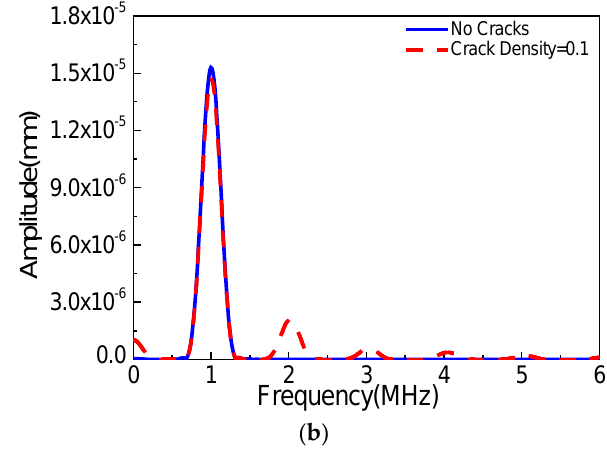
Figure 5. Wave signals in the x direction ( a ) time domain; ( b ) frequency domain ( c = 0.1, f = 1000 kHz, µ = 0.1, w % = 60%).